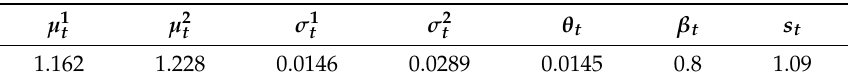
Table 3. The model parameter values.